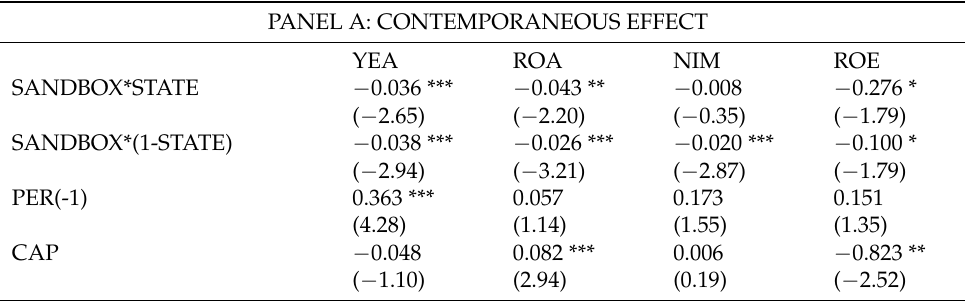
Table 8. Effect of FinTech firms on bank performance sorted by ownership. PANEL A: CONTEMPORANEOUS EFFECT YEA